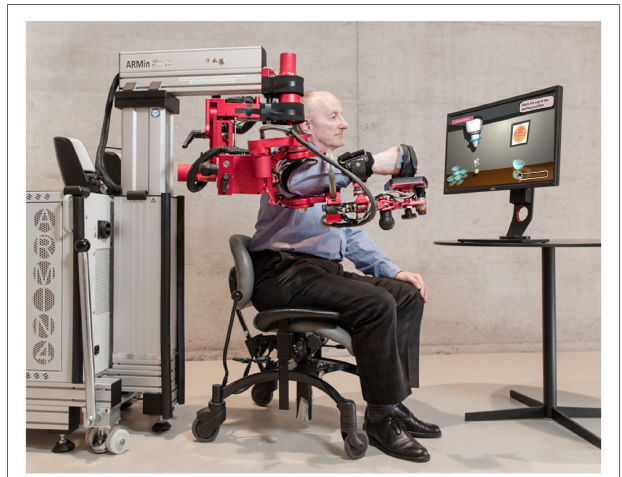
FIGURE 1 | ARMin IV is a 7 DoF robotic device for upper limb rehabilitation that incorporates position and force/torque sensors (Guidali et al., 2011)